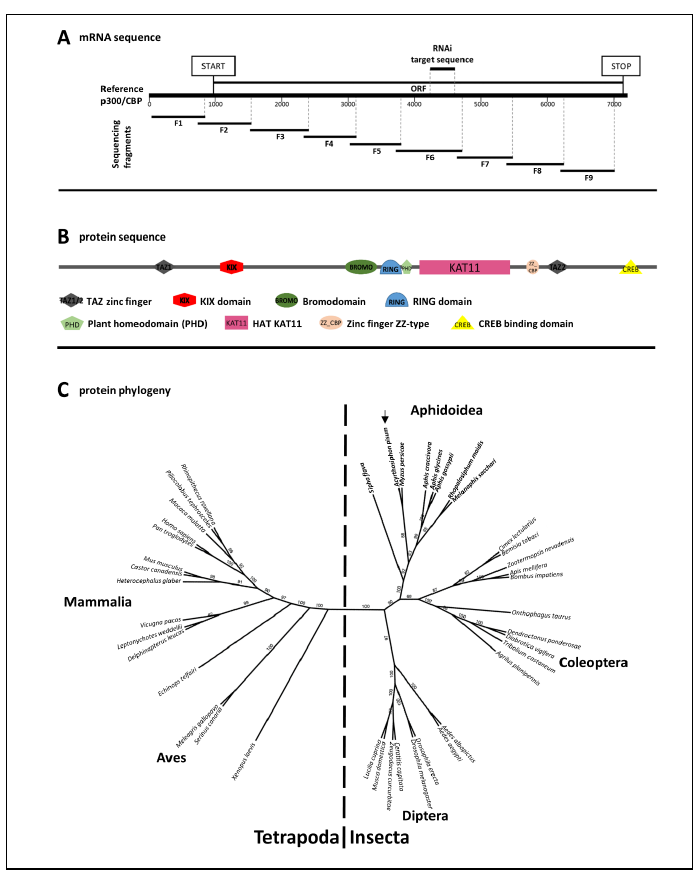
Figure 1. Characteristics of the p300 / CBP sequences used in this study. ( A ) The A. pisum p300 / CBP mRNA reference sequence (XM_008188962) is shown, the location of the open reading frame (ORF) as well as the RNAi target site is indicated. The orientation of the nine fragments obtained by cloning and Sanger-sequencing (Supplementary Fragments 1–9, Table S1) is depicted. These fragments were used for the assembly of A. pisum p300/CBP sequence. Our assembly contains the 5′ -UTR and most of the open reading frame (ORF) including the start codon, but not the stop codon and 3′ -UTR ( B ) Domain analysis of the p300/CBP protein sequence using Pfam and NCBI conserved domains databases. A complete set of p300/CBP typical domains was identified ( C ) Phylogeny of p300/CBP protein sequences. The tree was generated with RAxMl after MUSCLE alignment using amino acid sequence of A. pisum (black arrow/XP_003242232), Sipha flava (XP_025414151), Myzus persicae